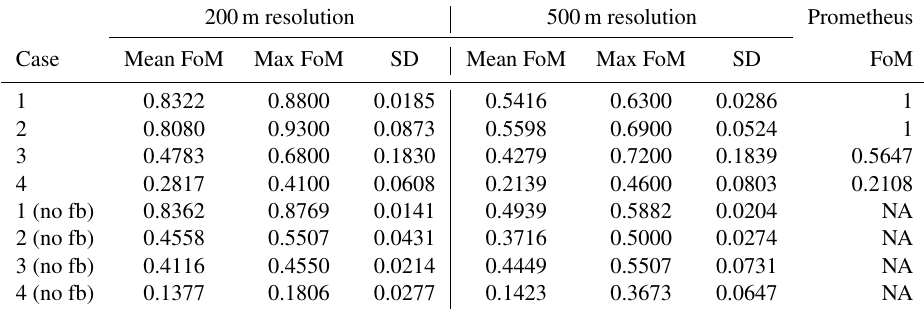
Figure 4. Ensemble maps for all four scenarios at two resolutions (200 and 500m). Graticule spacing for every map is 2000m except (i) , for which it is 500m. This is to help compare the size of each scenario. Panels (e) to (h) have the same spatial extent in order to show the relative size and locations of cases 3 and 4. Table 2. Figure of merit (FoM) descriptive statistics based on each run in an ensemble simulation; “(no fb)” specifies scenarios run with the fire–wind feedback